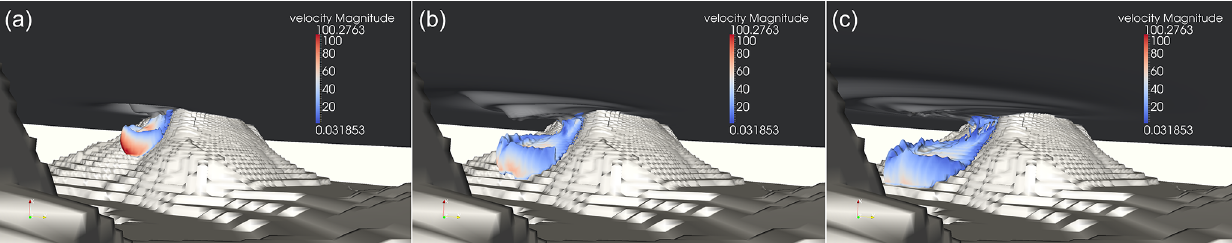
proximately consistent with a r − 1 propagation